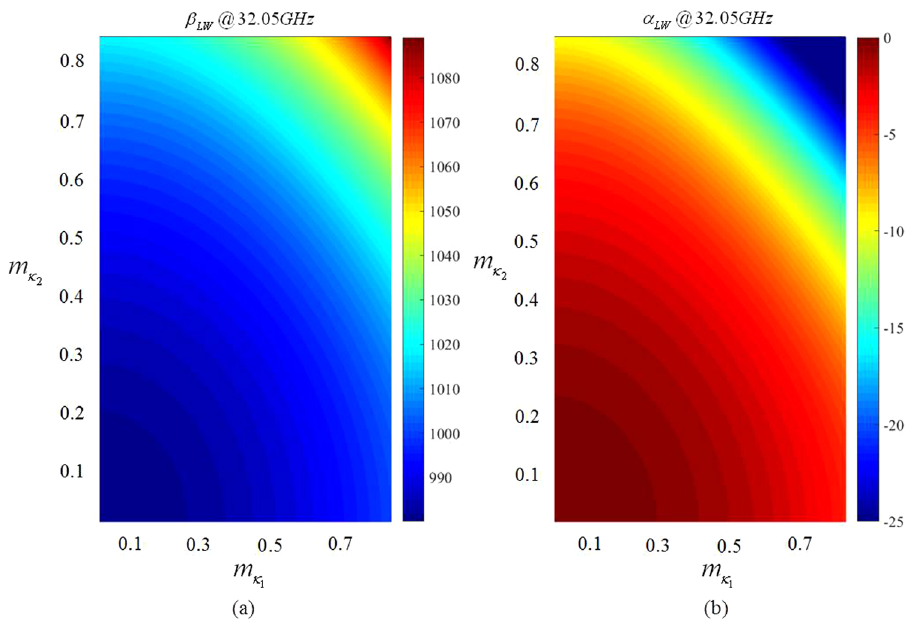
Figure 10. Maps of the leaky wave propagation ( a ) and attenuation ( b ) constants, evaluated at 32.05 GHz. The quantities are expressed as a function of m κ 1 and m κ 2 . The substrate used in this calculations is Rogers RO3010 with ε r = 10.2 and thickness h d = 0.635